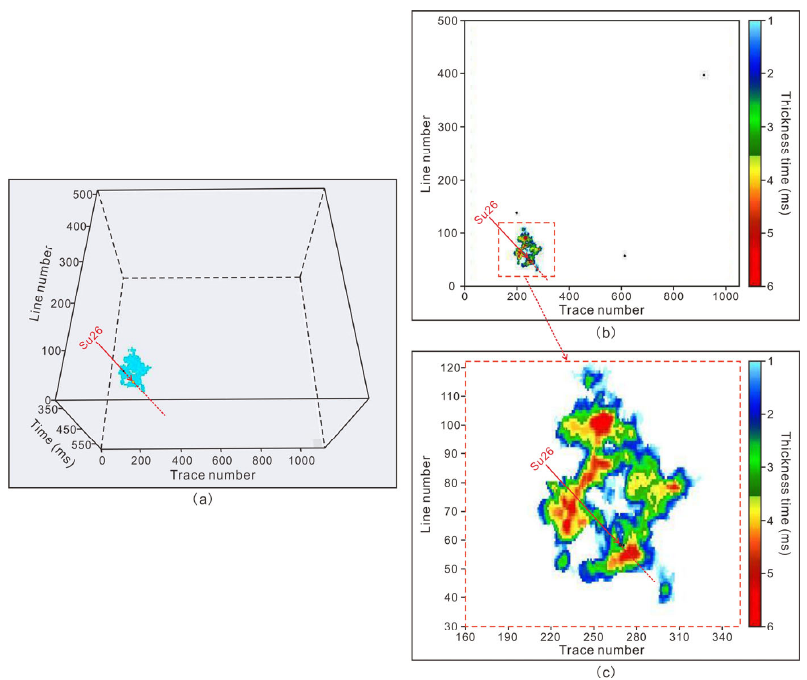
Figure 12. The 3D spatial range and its plane distribution characteristics along the target stratum of the sand body with uranium around Well Su26: ( a ) 3D spatial range, ( b ) Plane distribution characteristics extracted along the target stratum, ( c ) Local enlargement of the red rectangular dashed box in ( b ).